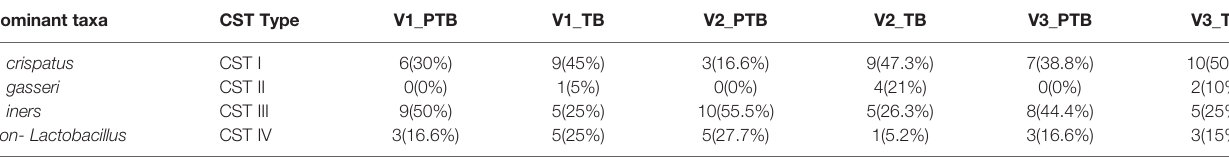
TABLE 3 | Result for CST distribution in term and preterm